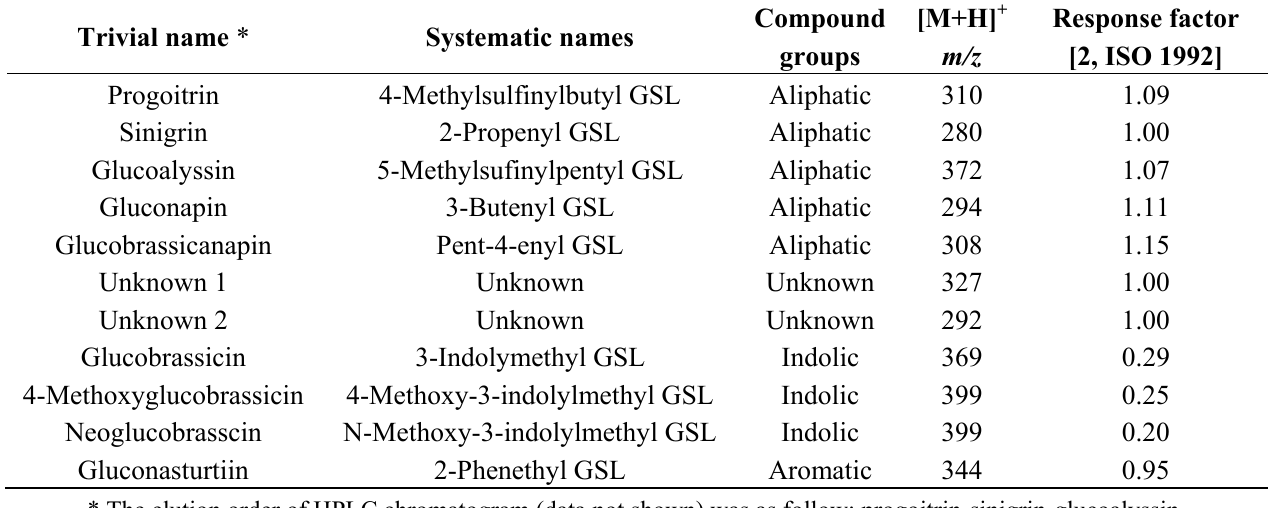
Table 2. Glucosinolates identified from Chinese cabbage by